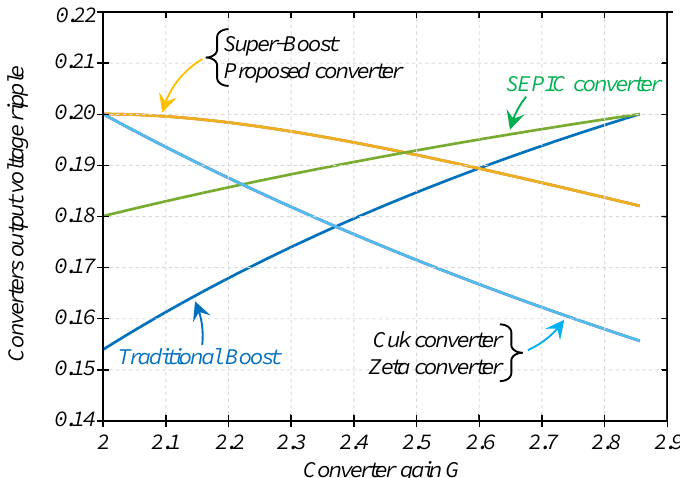
Figure 19. Output voltage ripple for all solutions in the full operation range vs. the converter gain G; they were designed to have an input current ripple of 0.6 A in the worst case; for all converters, the worst case is when G = 2.